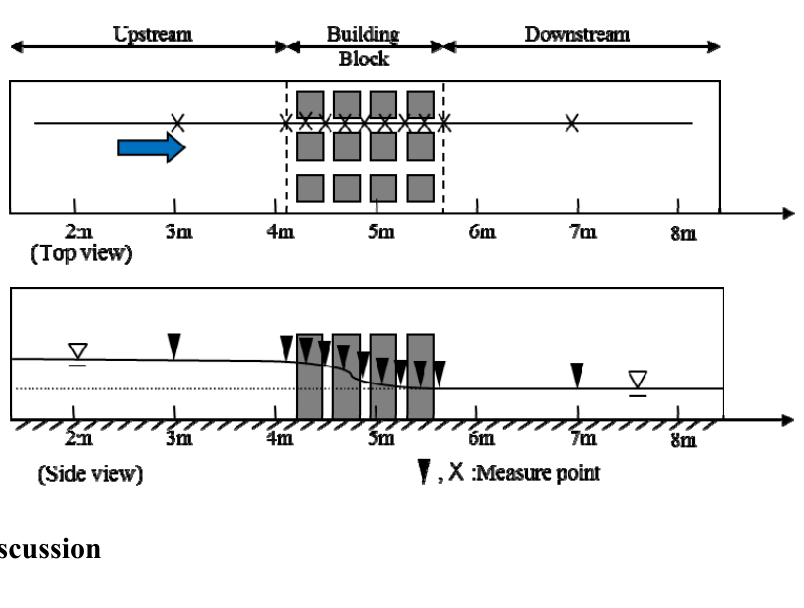
Figure 5. Measure positions of flow depth and